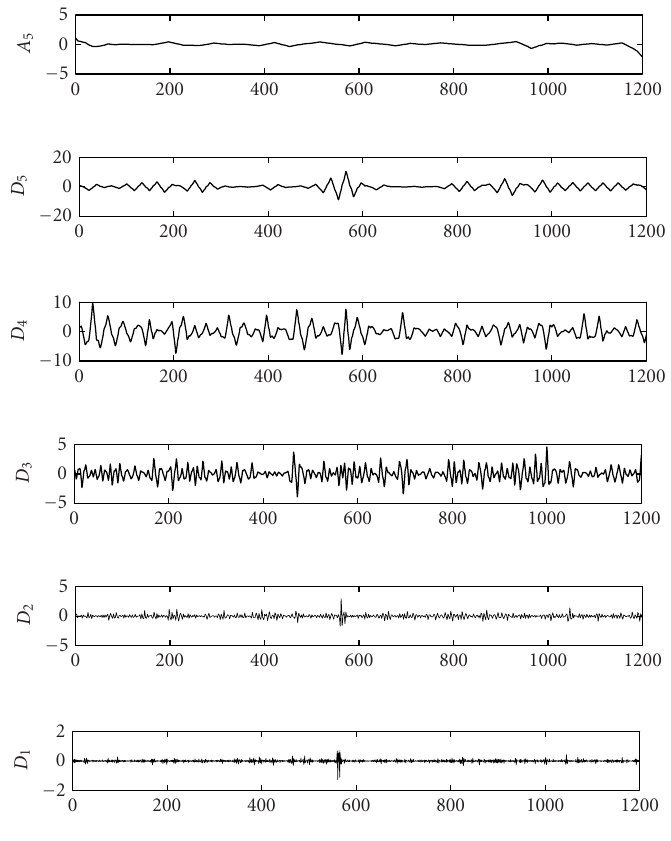
Figure 3.2. Approximation and details at level